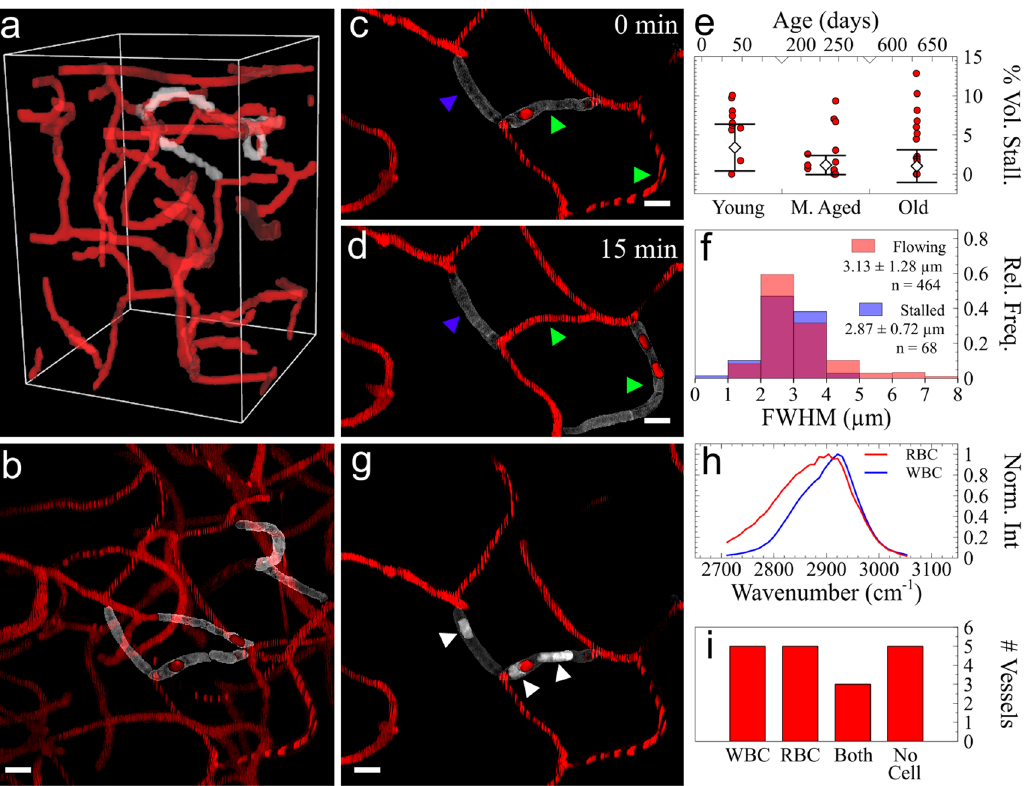
Fig. 2 Label-free in vivo imaging of mouse brain microvasculature with SNARF. a 3D rendering of mouse brain microvasculature. b Intensity projection of fl owing and stalled capillaries from a. c , d Repeated imaging of vasculature to identify stalled capillaries. e Comparison of stalled capillary volume to total vessel capillary between age groups. Error bars represent standard deviation. f Average vessel width between fl owing and stalled capillaries. g SRS imaging of WBCs stalled within vasculature, indicated by white arrowheads. h Spectral differences between RBCs and WBCs. i Frequency of WBC, RBC, both, or no cell observed in persistent stalled capillaries. Scale bars: 10 µ